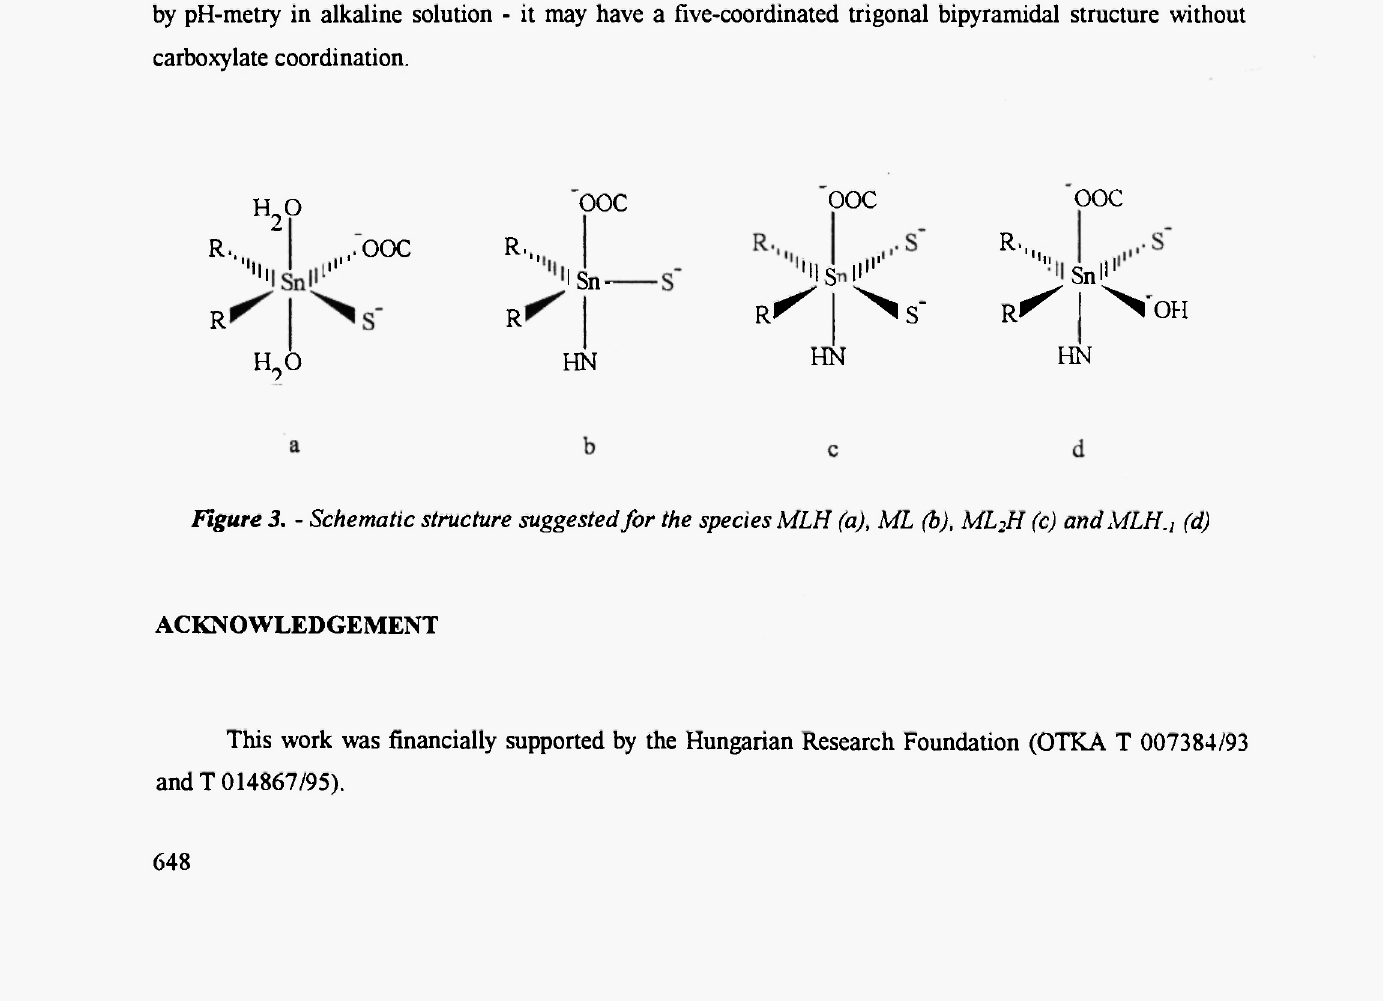
Figure 2. - The extrapolated curves by PSEQUAD for the 0.1 mol dm' 3 metal concentration